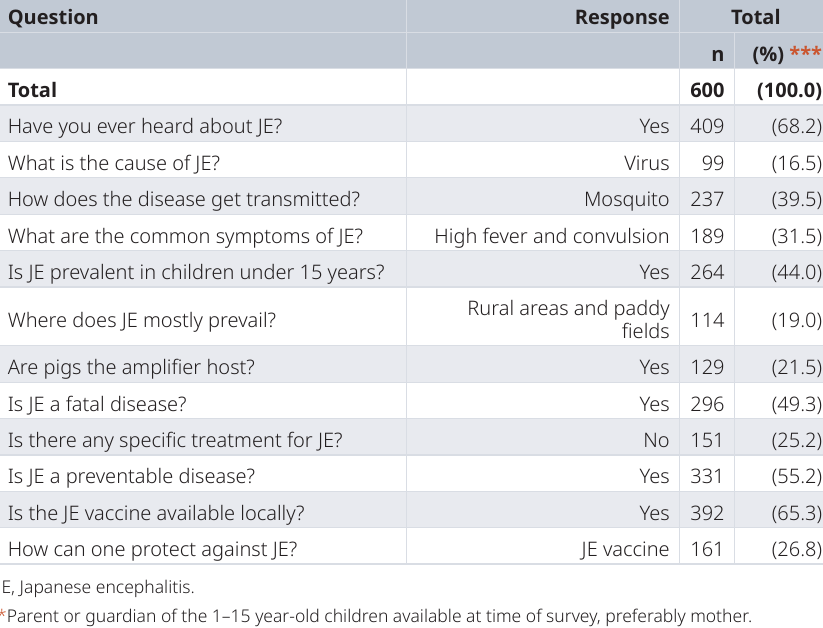
Table 2. Knowledge of participants * regarding cause, transmission, symptoms, prevention and treatment in the Japanese encephalitis survey, Yangon region, Myanmar (2019) **.